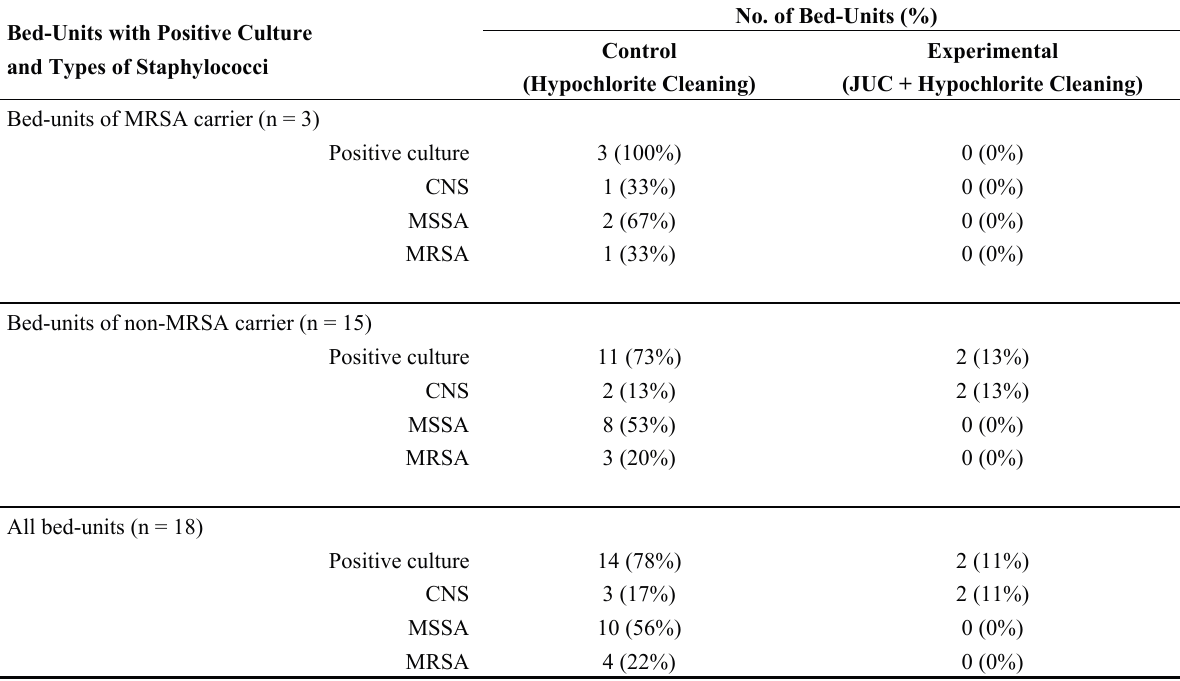
Table 4. Number of bed-units that showed a positive growth in staphylococcal bacteria according to the staphylococcal types recovered from the specimens collected four hours after the application of JUC